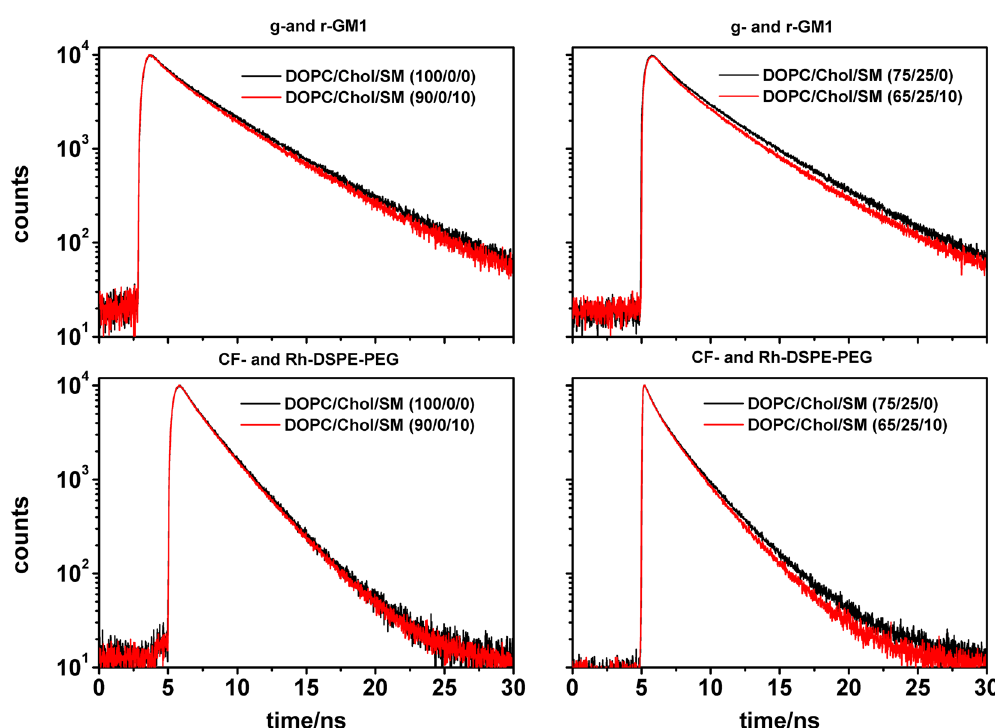
Figure 3. Experimental time-resolved fluorescence decays of the donor for the two D/A pairs and selected lipid mixtures with and without nanodomains (red and black fluorescence decays,